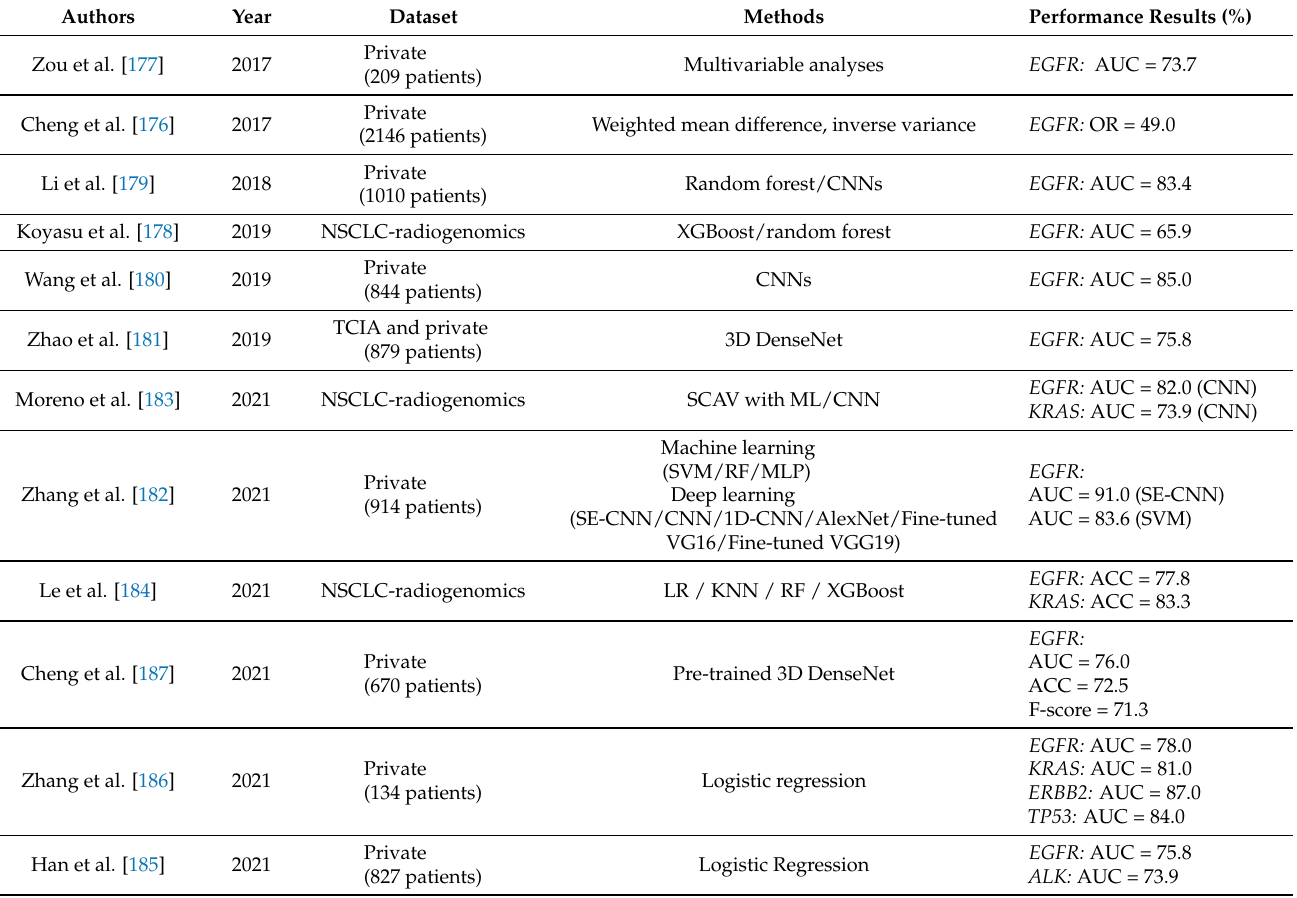
Table 6. Overview of published studies regarding predictive models for gene mutation status based on nodule features